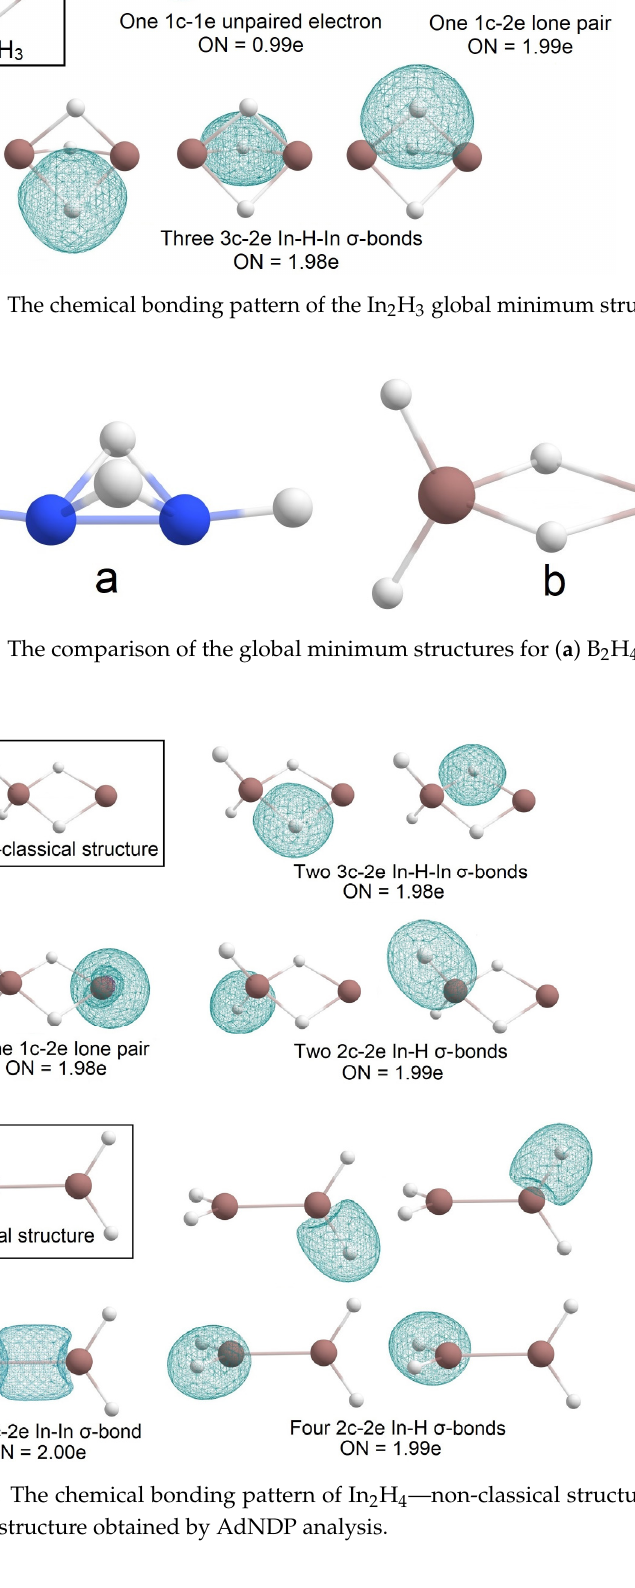
Figure 4. The chemical bonding pattern of the In 2 H 3 global minimum structure obtained by AdNDP analysis.